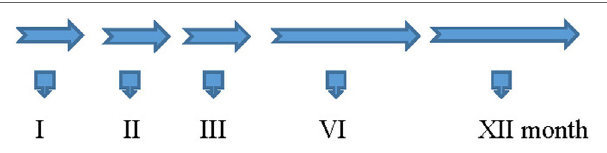
FiGUrE 2 | The treatment protocol